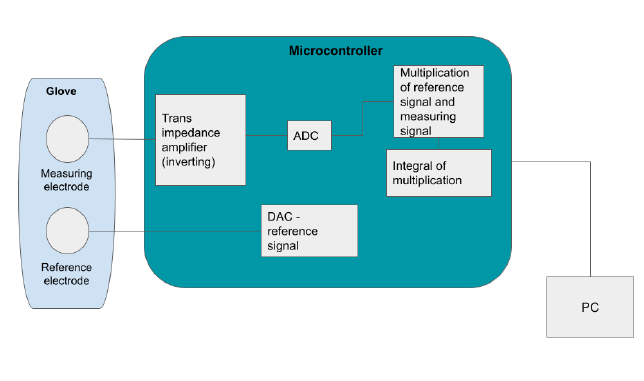
Figure 1: Functional design